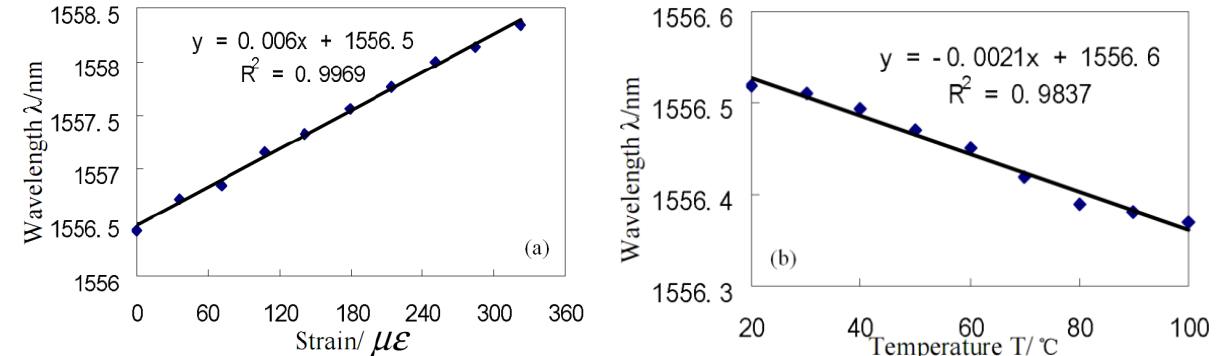
Figure 4. The characteristics of MFPI: ( a ) wavelength-temperature sensitivity; ( b ) wavelength-strain sensitivity.